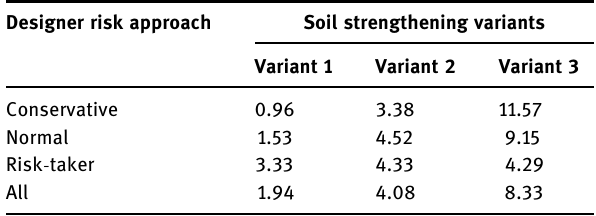
Table 11: Average frequency of selecting each working plot size